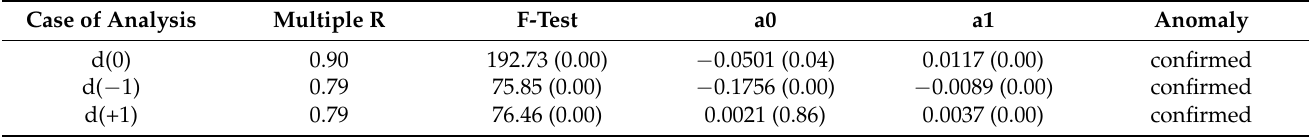
Table A5. Modified CAR approach: results of the expiration day price effects *.